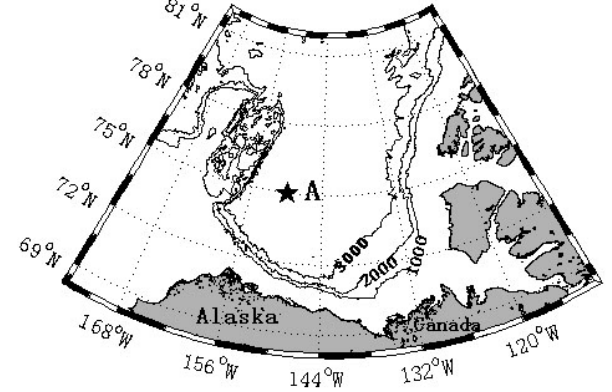
Fig. 3. Profiles of (a) potential temperature ( θ ) and (b) salinity ( S ) measured by conductivity–temperature–depth (CTD) at Mooring A on 28 Septermber 2010. The dashed line is the linear fit of the DC staircases in the salinity